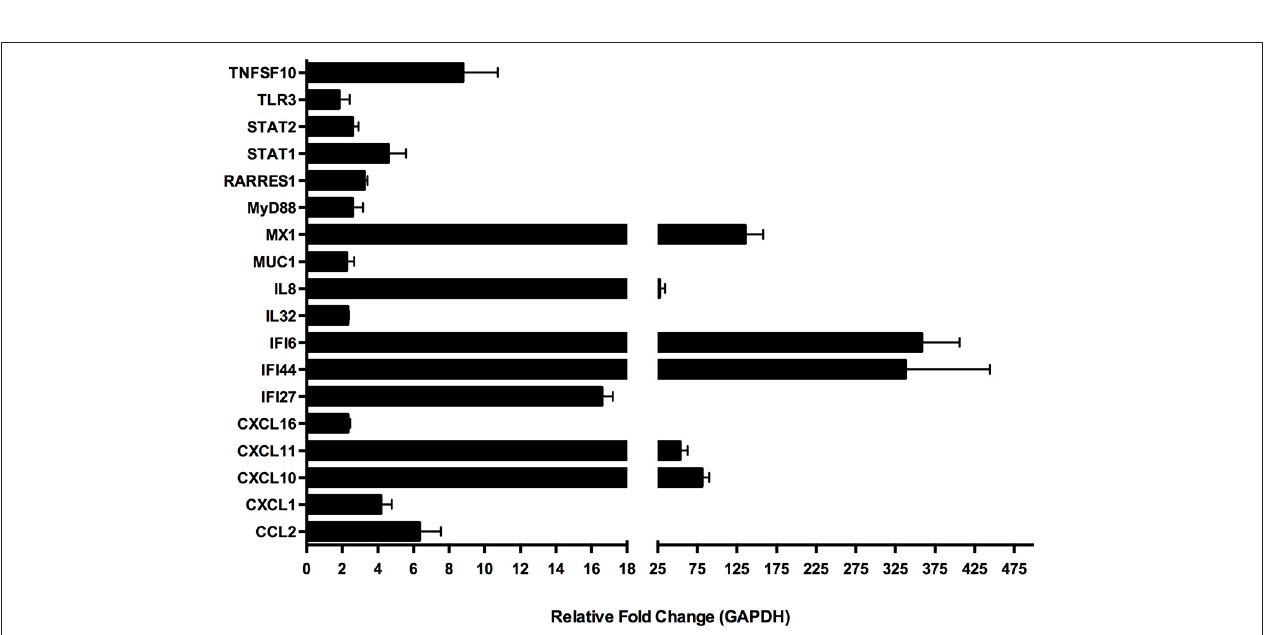
corresponds to an increase or decrease in fold change levels of spore treated cells compared to control. Genes in white did not exhibit significant changes in expression at 24h post inoculation with Alternaria. The network was generated with IPA (Ingenuity Pathways System).